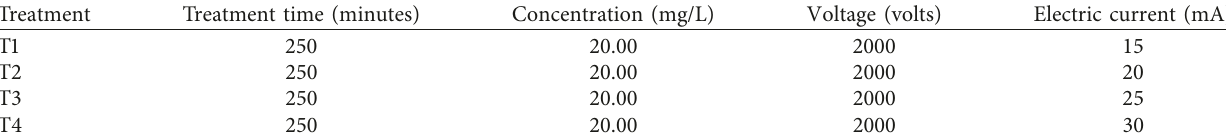
Table 1: Parameters considered for the realization of this experiment. Treated volume of contaminated water per experiment: 500mL. Treatment